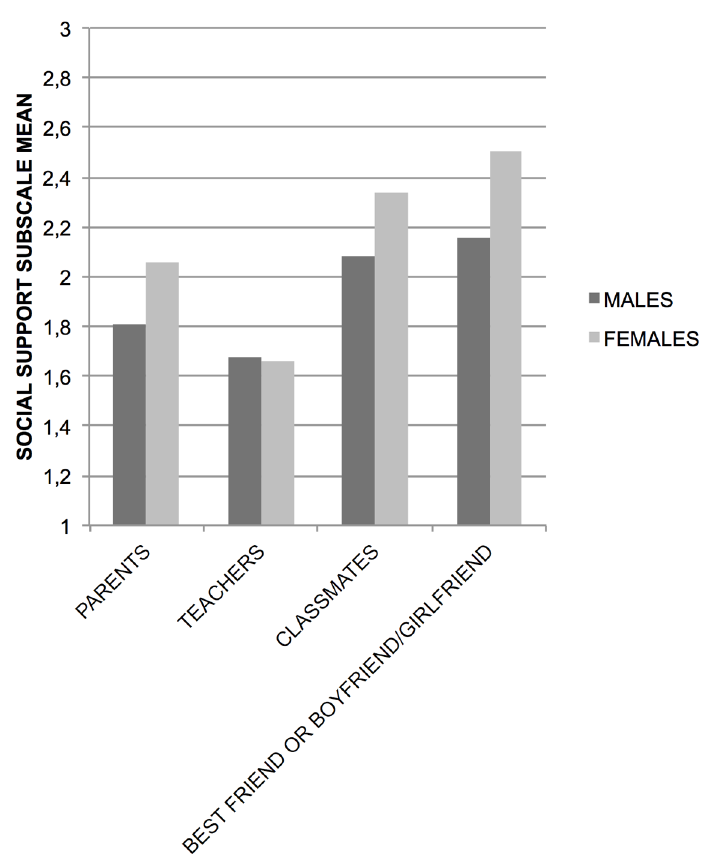
Figure 1. Perceived social support in college